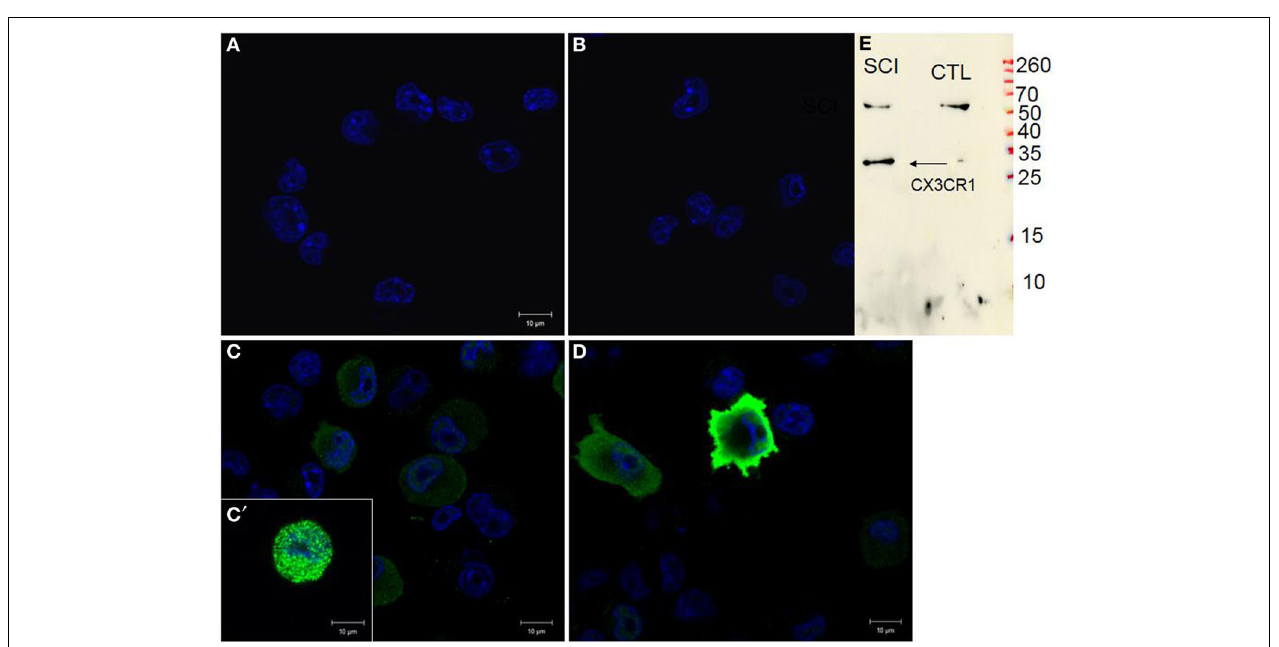
FIGURE 8 | Cross sections through dorsal white mater at the level of rostral(A)andcaudal (B)segmentsoftheinjuredspinal cordstainedwith CX3CR1 (red) and ED1 (green) antibodies revealing increased expression of CX3CR1 (red) in rostral segment compared to caudal (arrows). Note, no co-localization between CX3CR1 and ED1 labeled macrophages (see arrows indicated red dot for CX3CR1 labeling) (C , confocal image ) . Density of CX3CR1 + ( n = 4) and expression of CD206 profiles ( n = 4) in the spinal cord sections of sham and 3 days after SCI in White /Gray Matter (D,E) . (D) Density